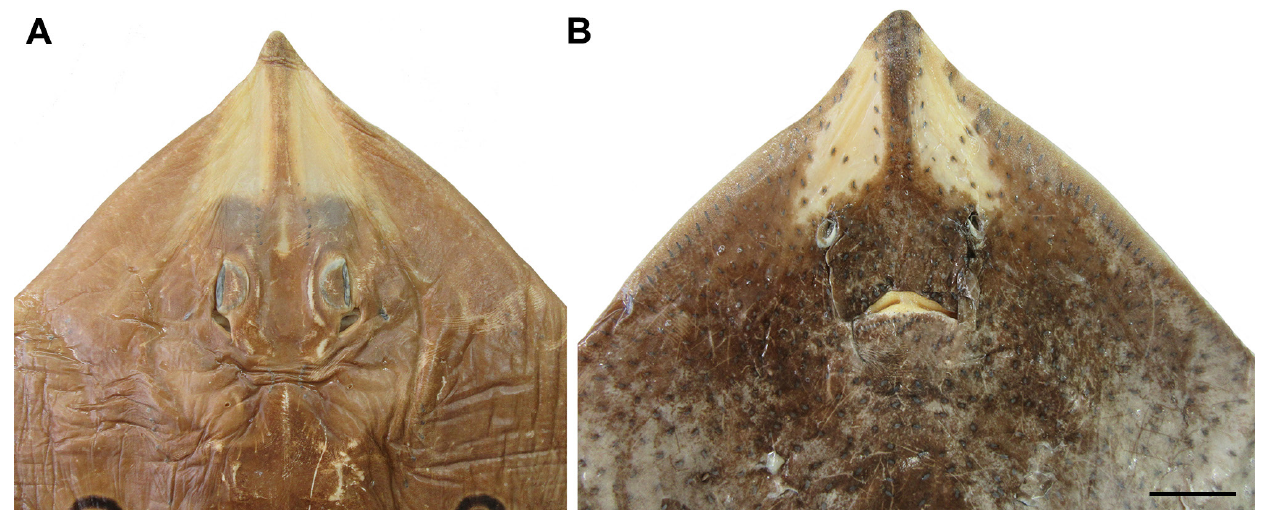
FIGURE 8 | Head region of Atlantoraja cyclophora , MNRJ 117184, female, 583 mm TL. A. Dorsal view. B. Ventral view. Scale bar = 10